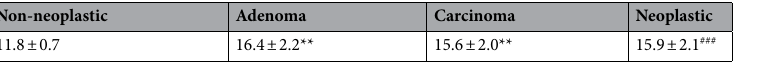
Table 1. Hydroxylation of lysine (Lys) in collagen from canine mammary tissues. Values represent mean hydroxylated residues/mole of collagen ± SD (non-neoplastic, n = 5; adenoma, n = 7; carcinoma, n = 9; neoplastic, n = 16). ** p < 0.01 between non-neoplastic and benign (adenoma) or malignant (carcinoma) mammary gland tumors via Kruskal–Wallis followed by a Dunn’s multiple comparisons test. ### p < 0.001 between non-neoplastic and neoplastic (combined adenoma and carcinoma) mammary gland tumors via an unpaired Student’s